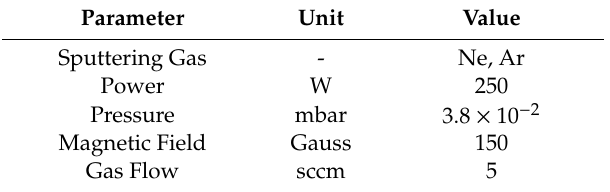
Table 1. Parameters of DC magnetron sputtering for amorphous carbon thin